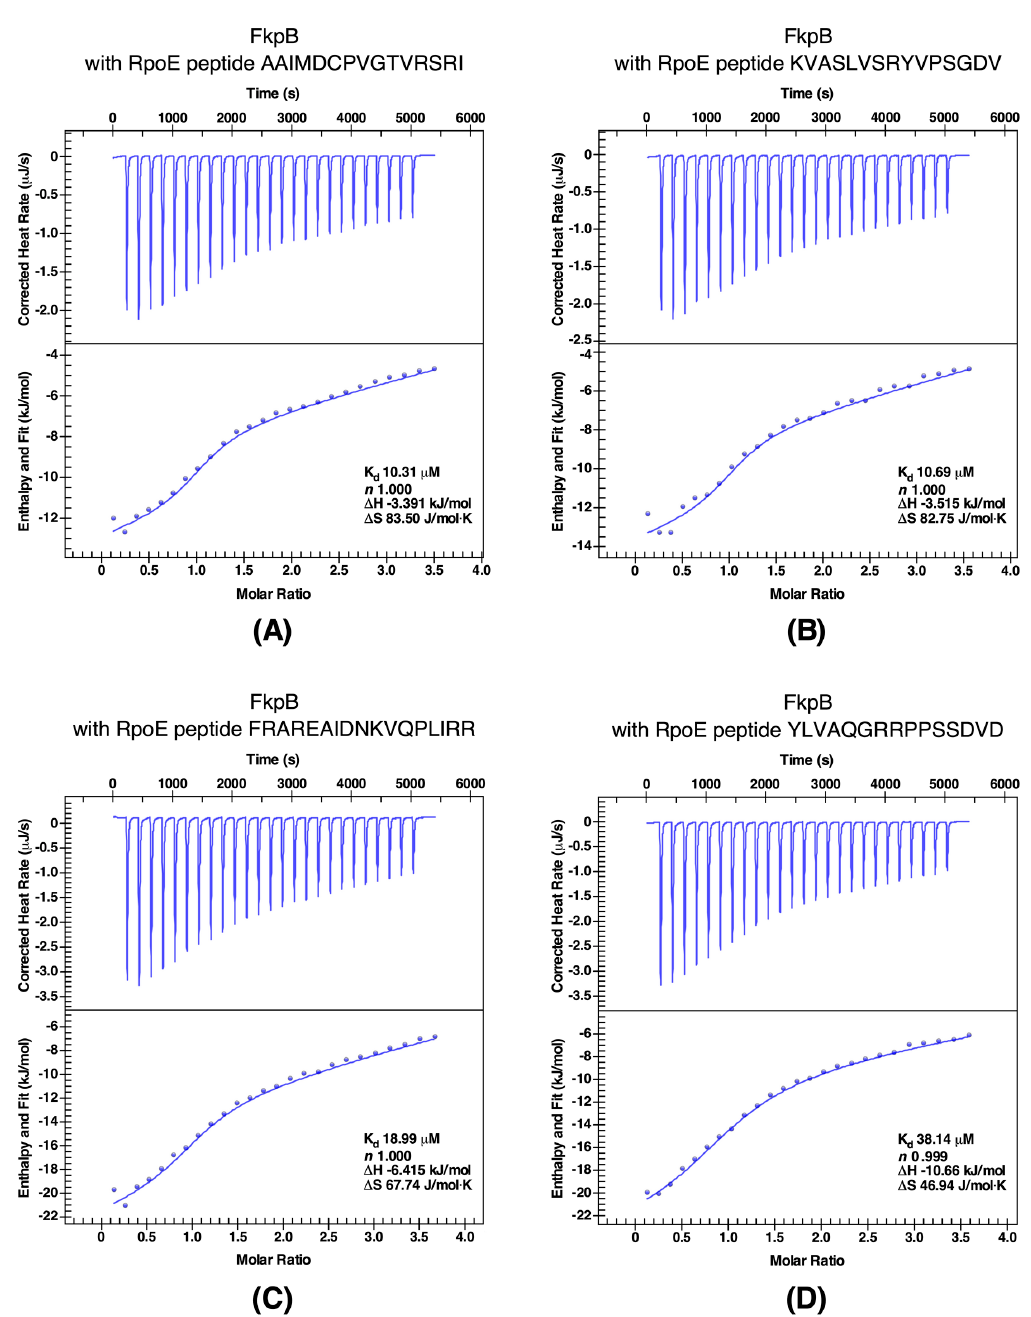
Figure 7. Quantification of binding affinity of FkpB with four different peptides derived from RpoE (Panel A – D ). FkpB was titrated into peptides indicated on the top of each panel in ITC cell. Raw data (top half of each panel) and integrated heat measurements enthalpy (bottom part) are shown. The calculated stoichiometry ( n ) and dissociation constant ( K d ) are indicated in insets. Since the anti ‐ sigma factor RseA also co ‐ elutes with FkpB, binding affinities were measured using ITC with peptides covering the most conserved regions in the N ‐ terminal domain of RseA. Thermograms of two best binders are presented (Figure 8B,C). Peptide Rse1 corresponding to amino acid 2 ‐ 29 of N ‐ RseA binds to FkpB with a K d of 15.08 μ M and with a stoichiometric value ( n ) of 1.002 (Figure 8B). Similarly, a high affinity binding with a K d of 13.02 μ M was observed with peptide Rse3